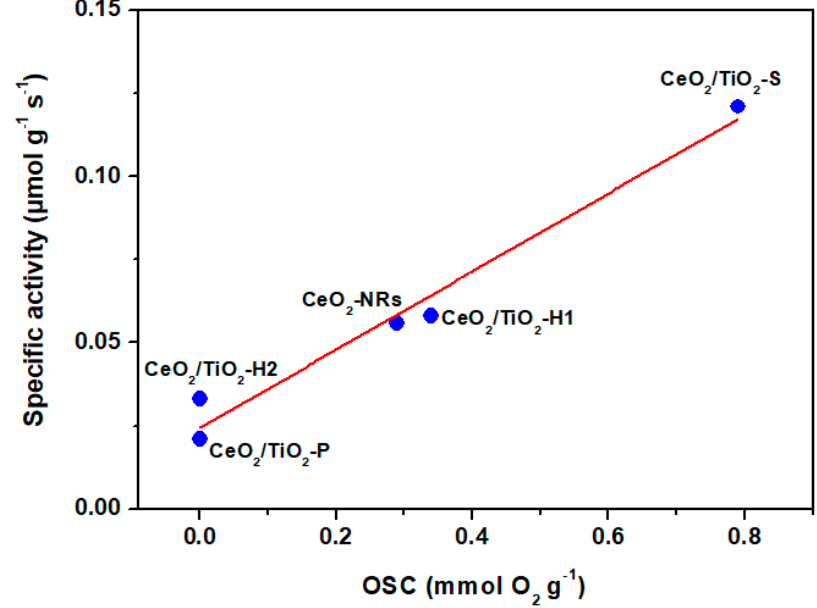
Figure 7. Relationship of the specific activity and the oxygen storage capacity of as-prepared samples.